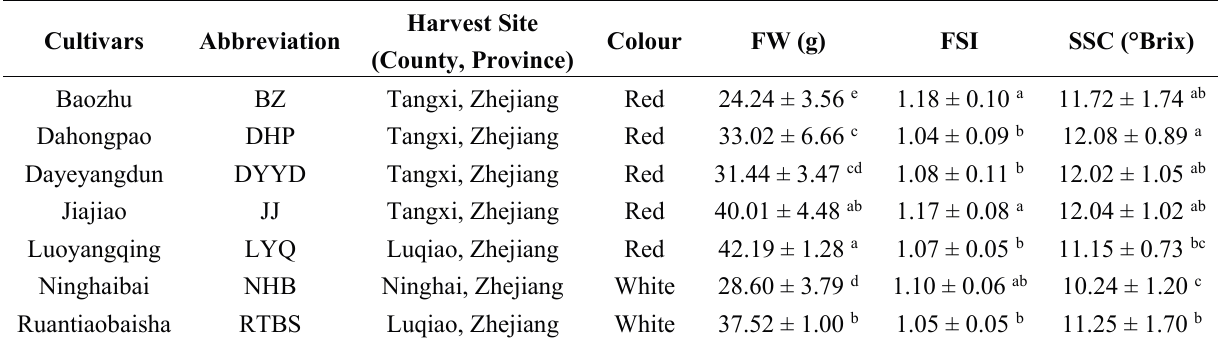
Table 1. Cultivars used in the present study and their basic fruit quality